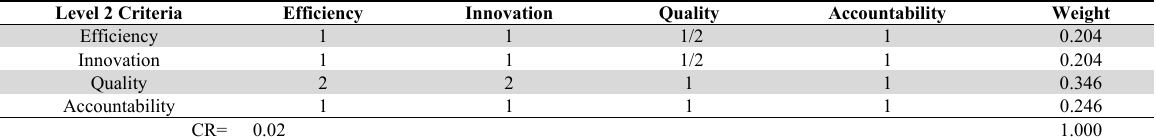
Pairwise comparison matrix aggregation for the main criteria